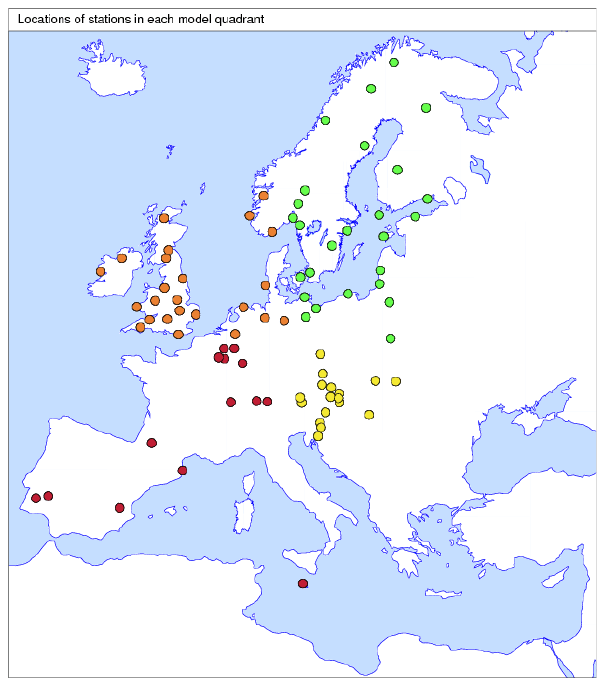
Fig. 6. Colour coded locations of the stations in each model quad- rant used to derive the seasonal variation plots in Fig. 5 in the